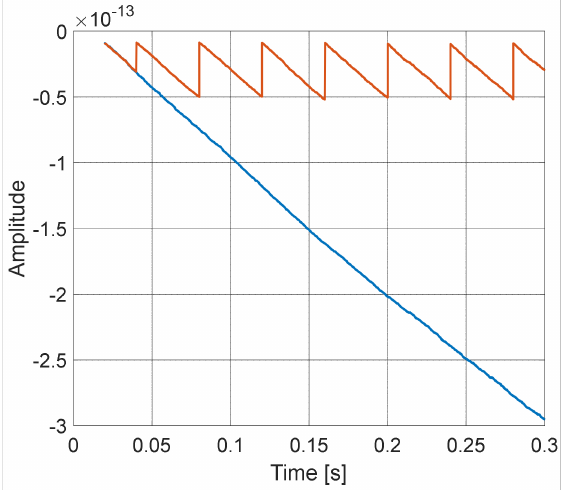
Figure 9. Error amplitudes on the output of first harmonic detector. Classical (blue curve), switching (red curve).